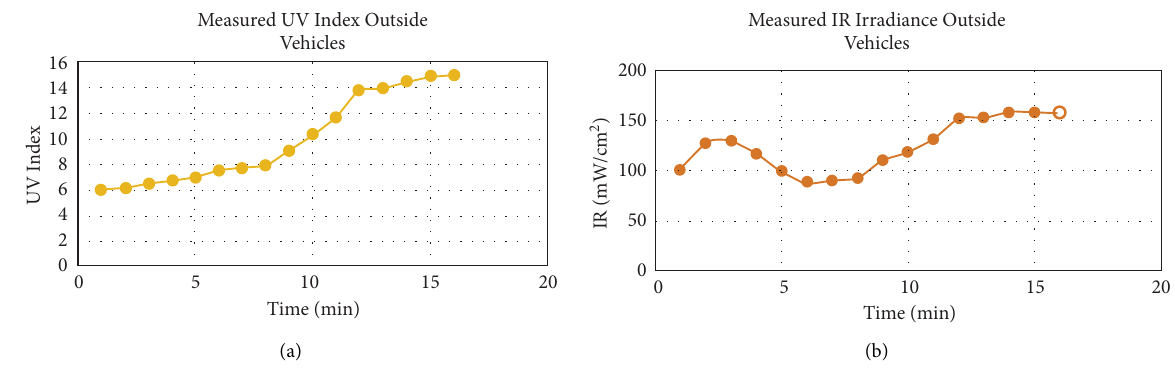
Figure 13: (a) UVI measurements outside the vehicles for sixteen minutes. (b) IR measurements outside the vehicles for sixteen minute.